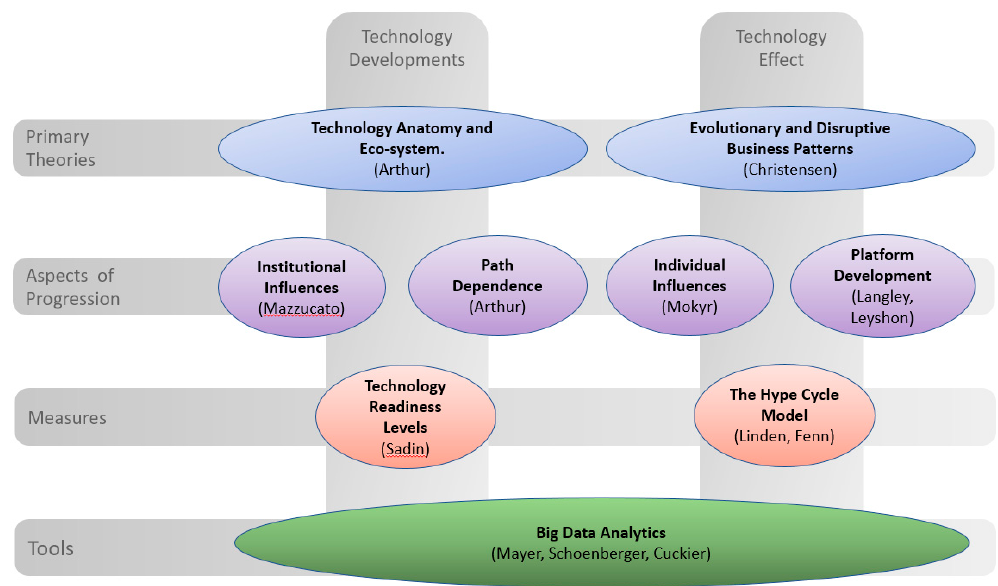
Figure 5. Framework for integrating different research into disruption.